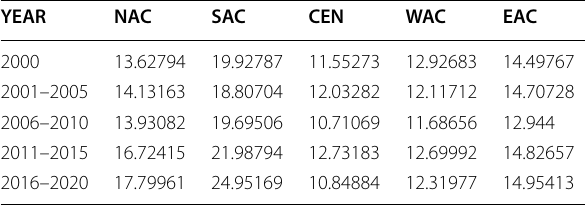
Table 1 Trend of Government Spending in Africa